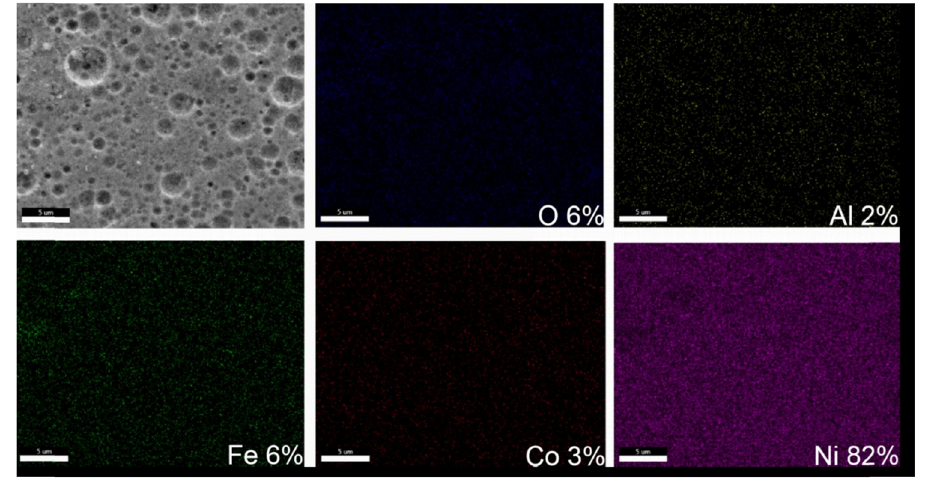
Figure 4: EDS diagram of the surface of the lower wrench treated with 20 V for 60